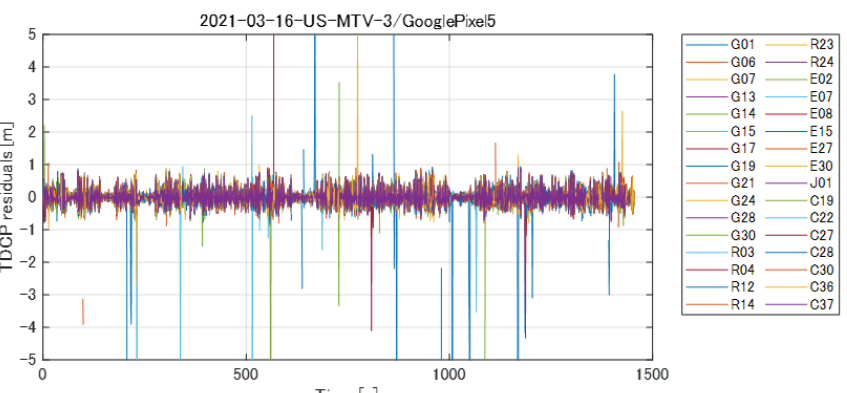
Figure 4. TDCP residual of L1 signals computed by Equation (4). The Doppler observation is used to detect and exclude cycle slips in the carrier-phase